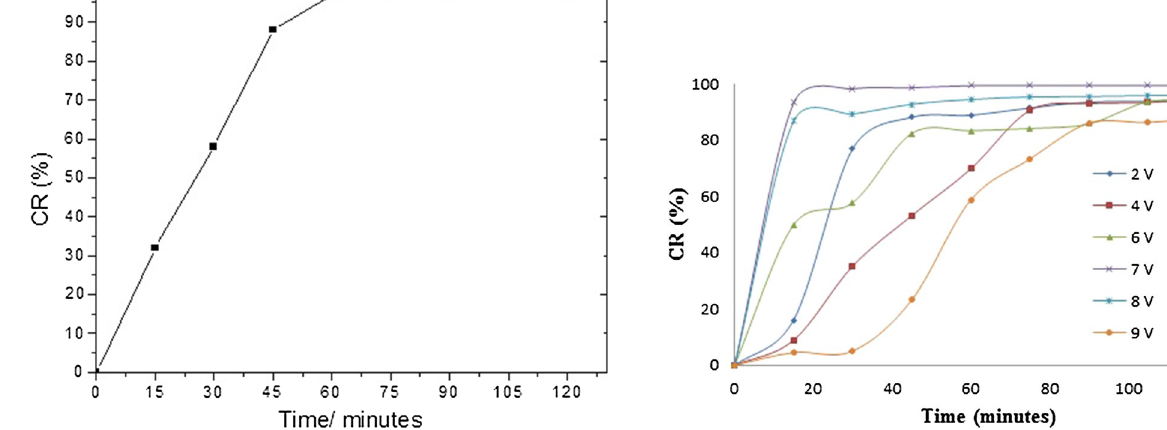
Fig. 3 Effect of time on the removal efficiency of Eriochrome Black 0.20 g L −1 . [NaCl] = 1.0 g L −1 ; electrolysis time = 120 min; pH 7.0; and E = 7.0 V